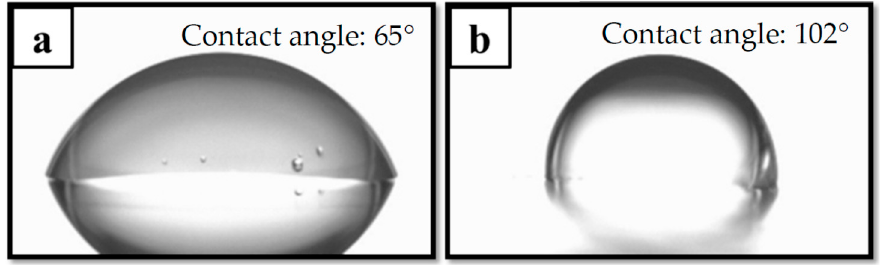
Figure 3. Water contact angle images for the PMP ( a ) without and ( b ) with SiC x H y /three-pair SiO x /SiC x H y stack.